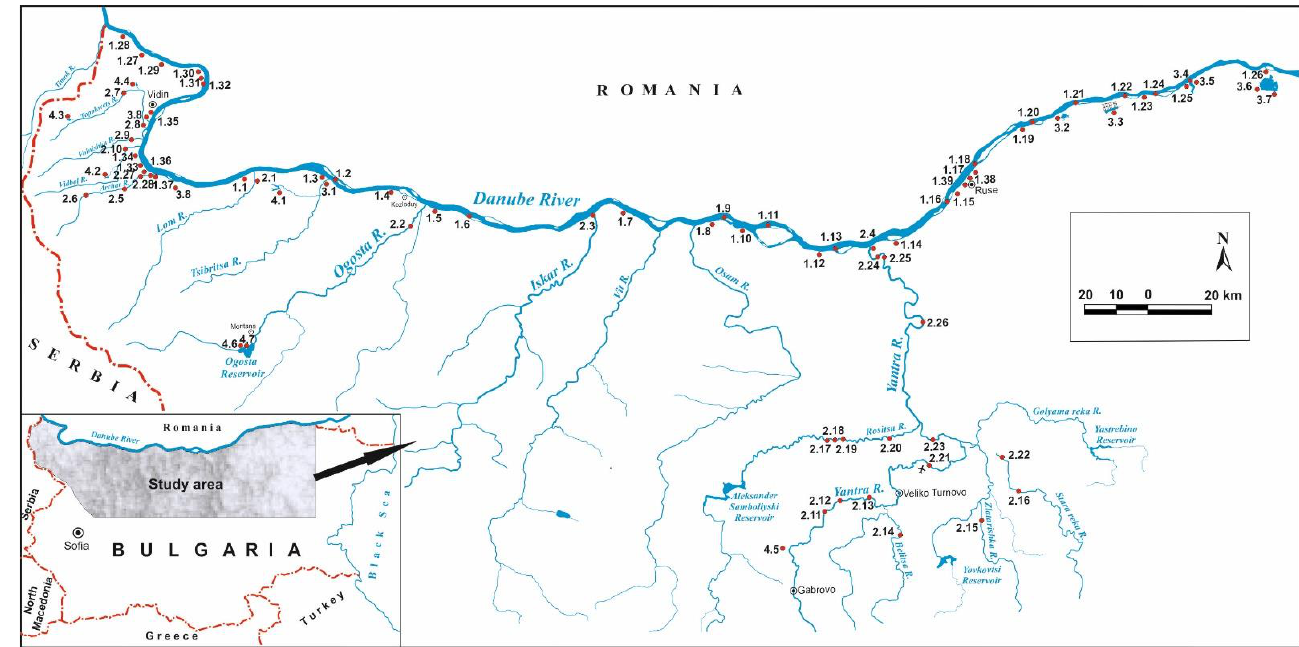
Figure 1. Map of the study area and sites (indicated with red dots) in the Danube River Basin (Bulgaria) during JDS4 (2019). For numbers of sampling sites, please see Supplementary Materials (Supplementary Table S1).